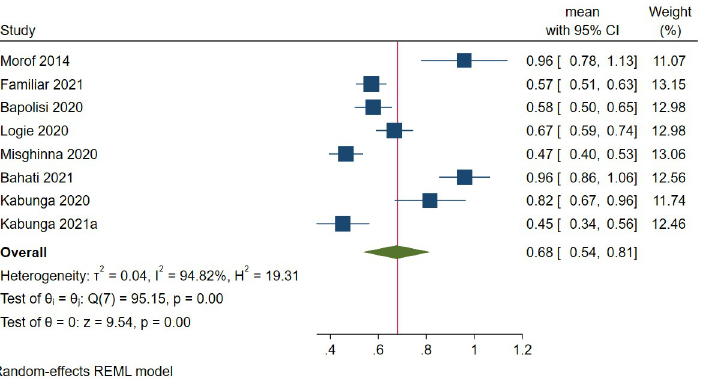
Fig 5. Forest plot on the prevalence of depression among refugees in